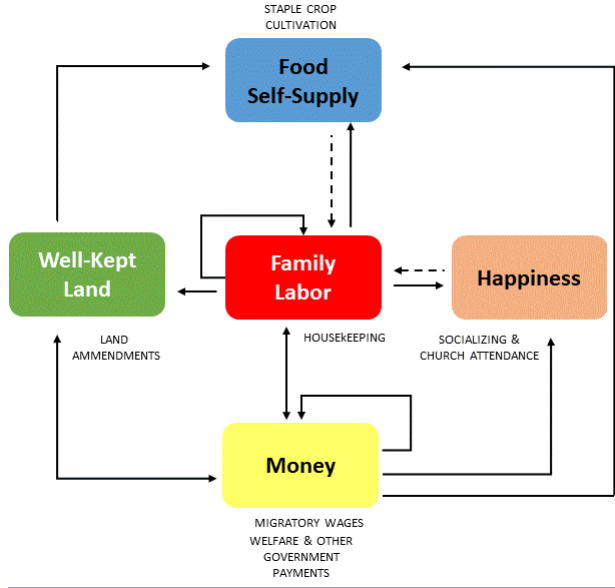
Fig. 1. Stylized model of interdependence among capacities employed by rural households to reproduce their livelihoods. Arrows indicate that the capacity from which the arrow emanates is required to reproduce the capacity to which the arrow points. Dotted arrows indicate that the capacity may or may not be necessary to reproduce the targeted capacity.